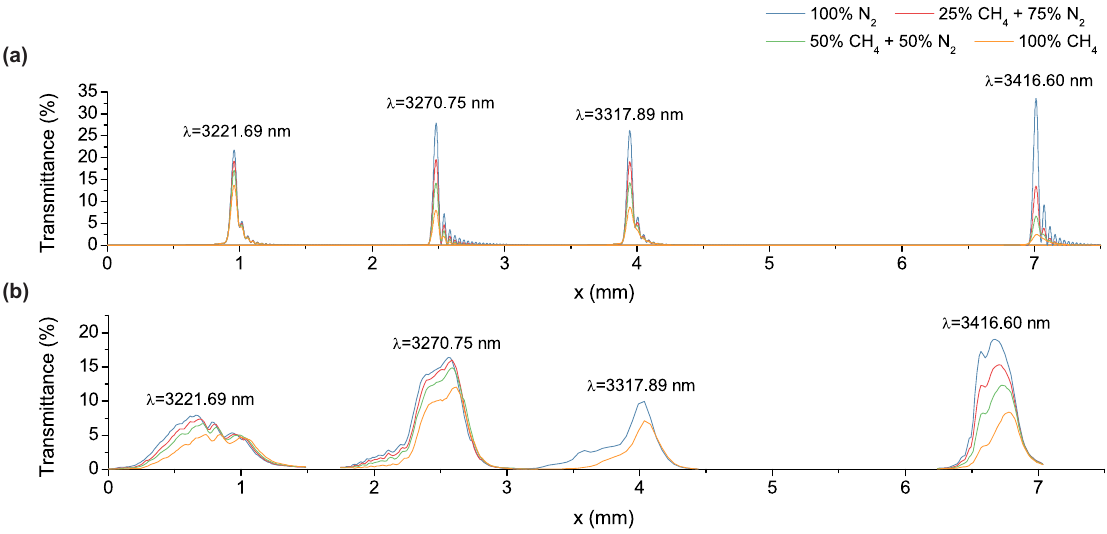
Figure 9. The wideband spectral response of the gas-filled LVOF with various mixtures of methane and nitrogen ( a ) simulated using the measured profile of the mirrors and ( b ) measured using the optical parametric oscillator (OPO) laser at the wavelengths of 3221.69nm, 3270.75nm, 3317.89nm and